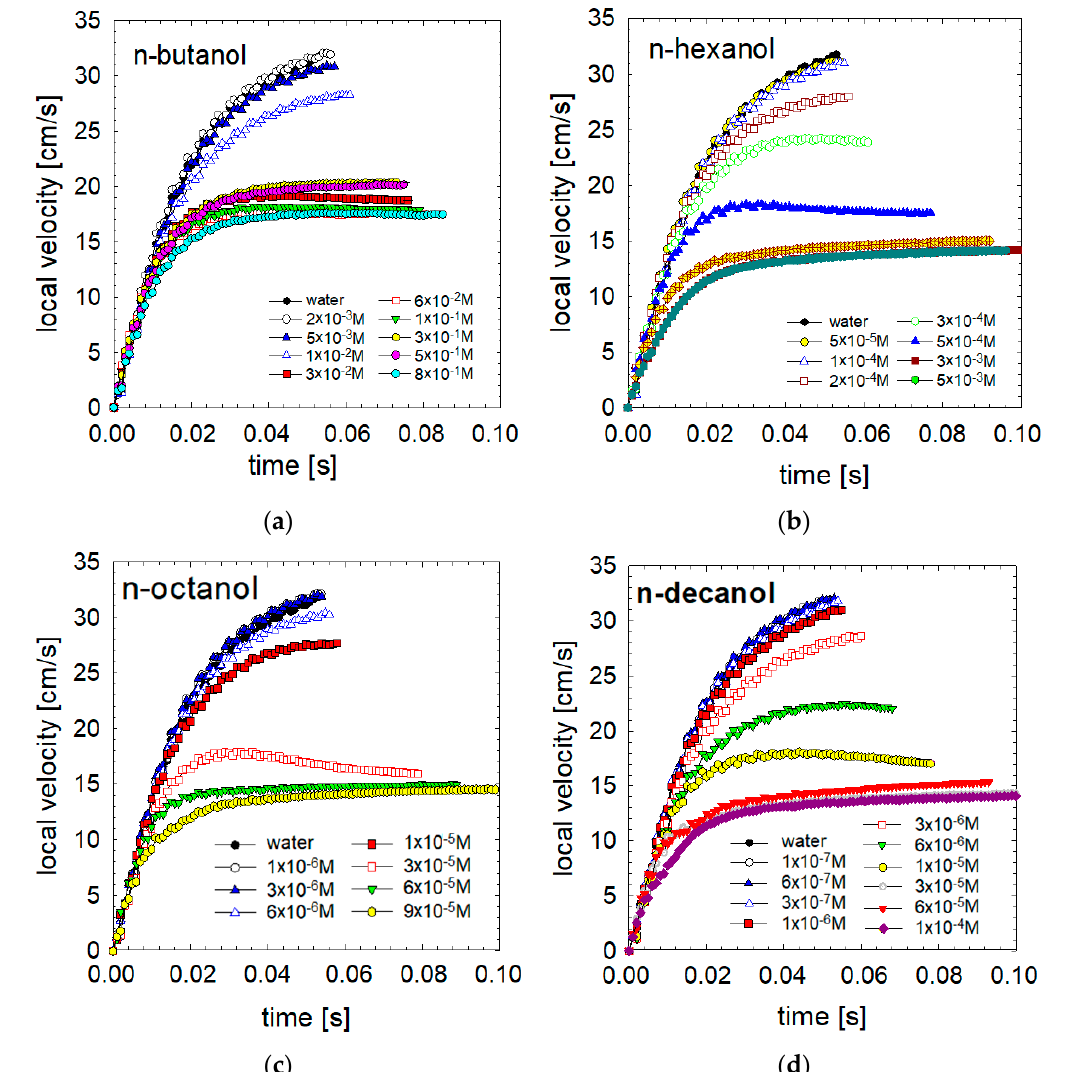
Figure 4. Detailed velocity profiles (for acceleration stage of motion) as a function of solution concentration in ( a ) n-butanol, ( b ) n-hexanol, ( c ) n-octanol and ( d ) n-decanol solutions of different concentrations.